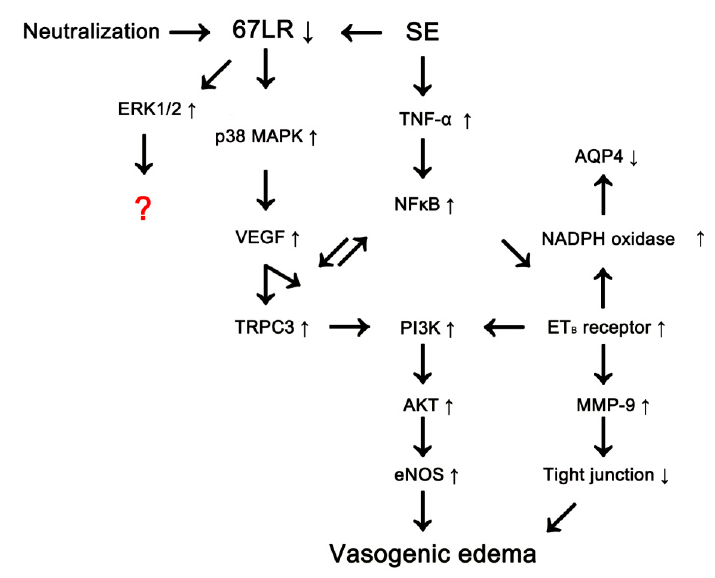
Figure 1. Scheme of vasogenic edema formation.